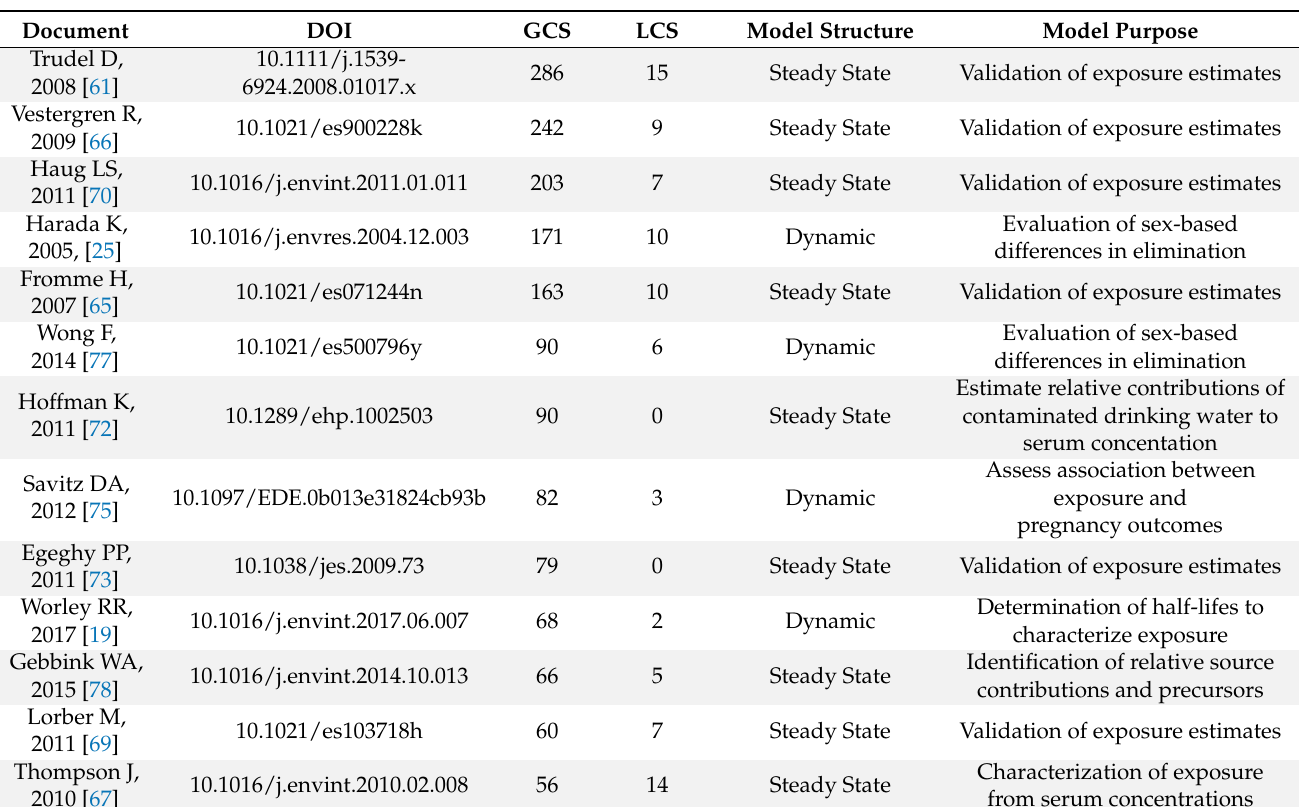
Table 3. One Compartment Human Models with over 50 Global